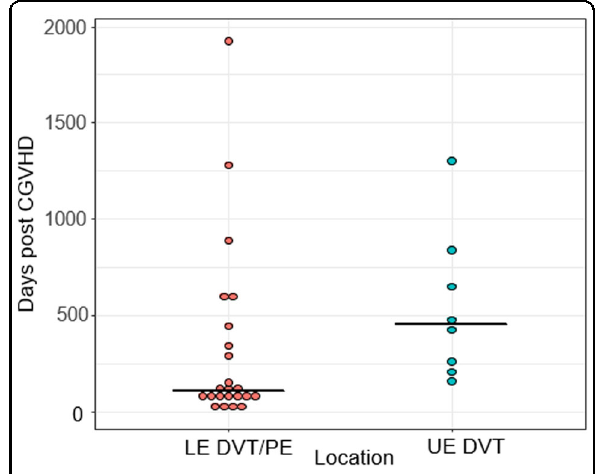
Fig. 1 Dot plot of thromboembolic events. Each dot represents a unique event. Lower extremity (LE) deep vein thrombosis (DVT) events are displayed with pulmonary embolism (PE) events on the left. Upper extremity (UE) DVT events are displayed on the right.